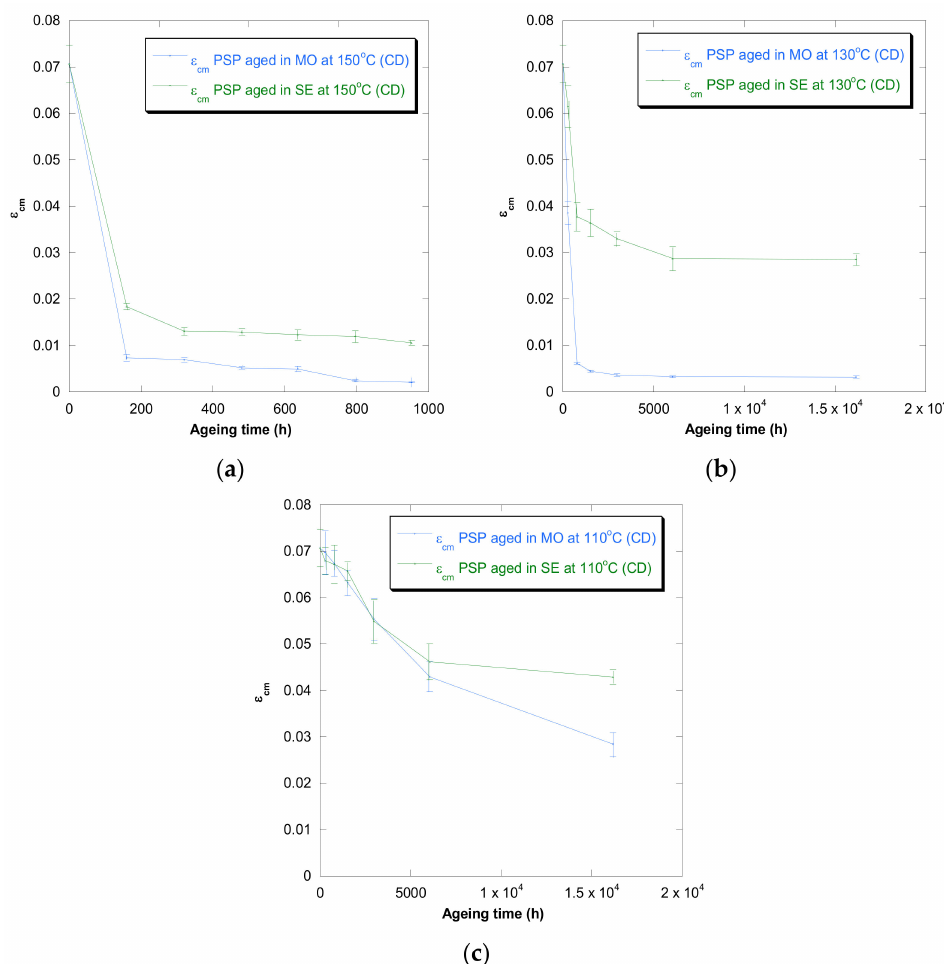
Figure 5. Evolution of the ε cm in CD as a function of temperature for cellulose-board PSP 3055 aged in mineral oil and in synthetic ester at 150 ◦ C ( a ), 130 ◦ C ( b ), and 110 ◦ C ( c